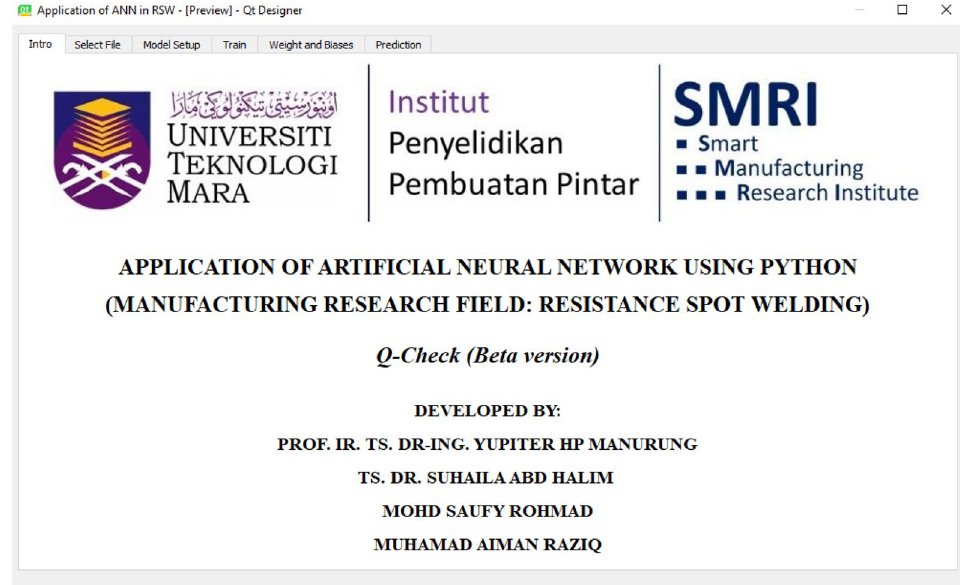
Figure 5. Introductory tab of Q-Check application tool as Tab 1.